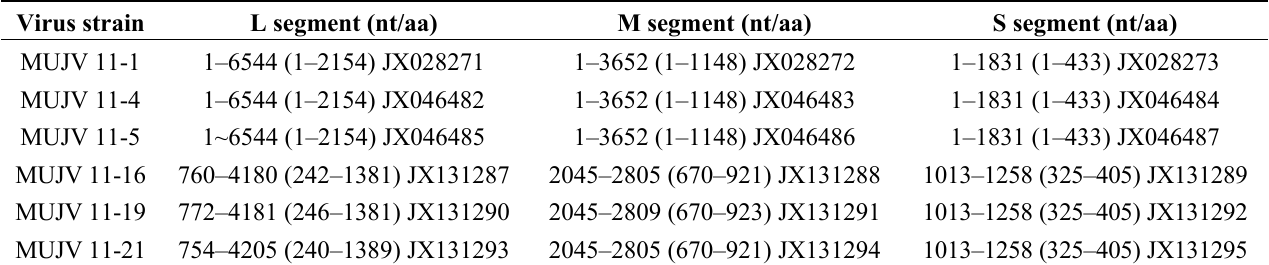
Table 1. Nucleotide and amino acid sequence summary of MUJV strains 11-1, 11-4,